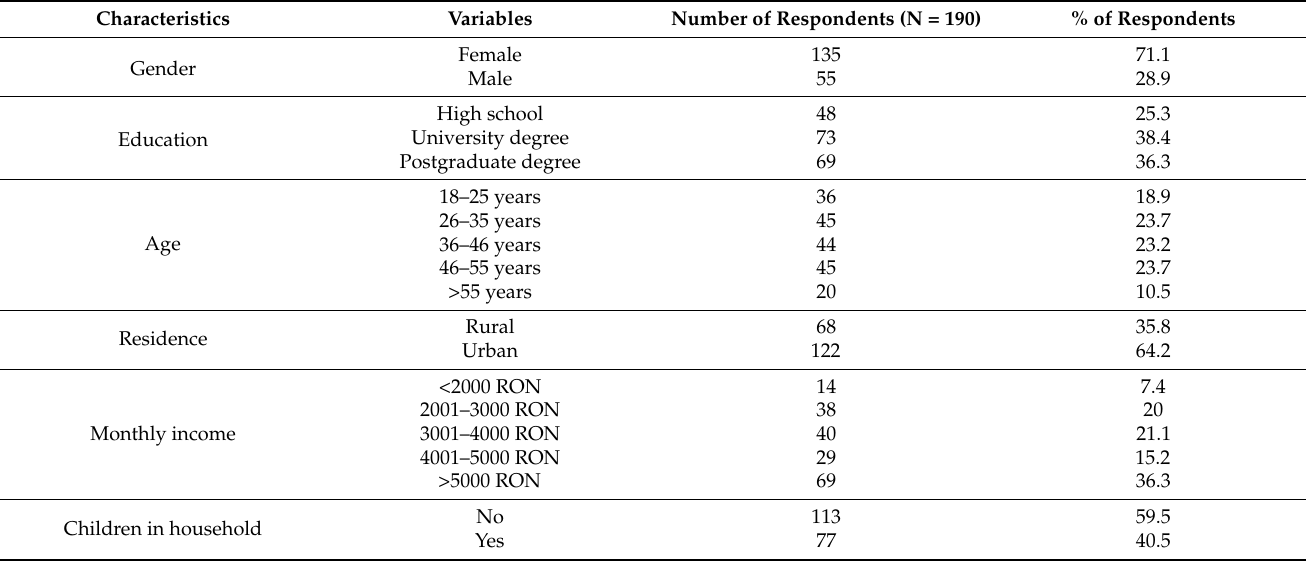
Table 1. The socio-demographic profile of the